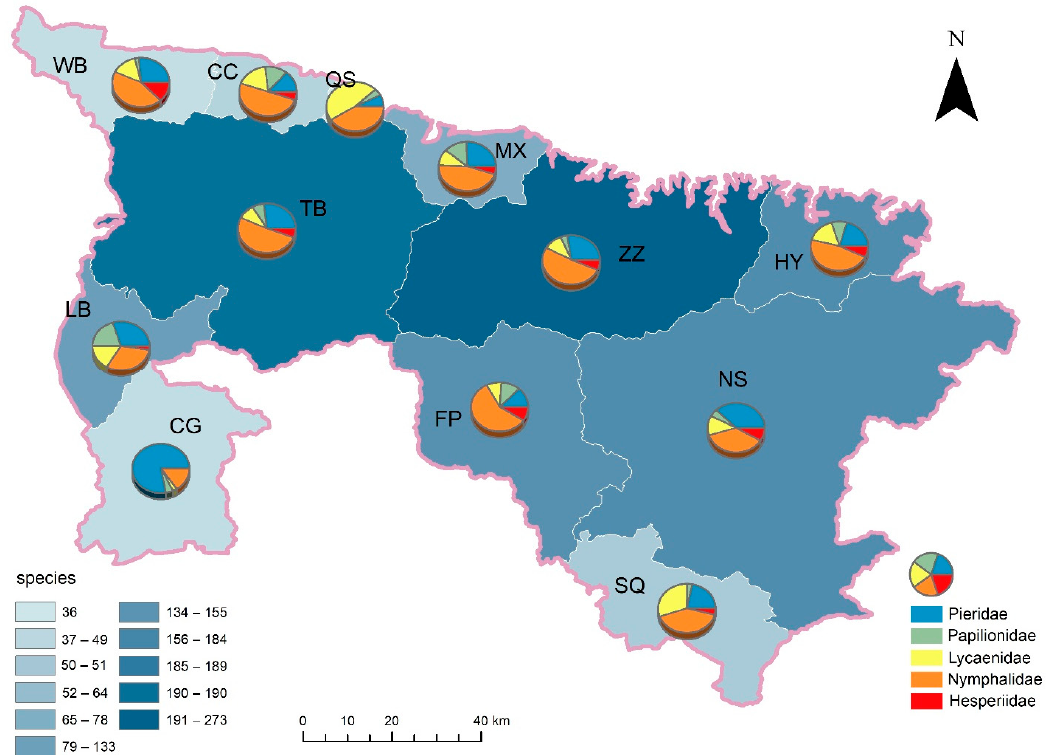
Figure 2. Spatial distribution of species richness in 12 ecoregions. The pie charts represent the pro- portions of 5 butterfly families. The counties are Zhouzhi County (ZZ), Huyi District (HY), Meixian County (MX), Taibai County (TB), Qishan County (QS), Chencang District (CC) and Weibin District (WB), Liuba County (LB), Chenggu County (CG), Foping County (FP), Ningshan County (NS) and Shiquan County (SQ). Table 1. Diversity indices of butterfly communities in the middle Qinling Mountains (mean ± SE). No. of No. of Family Genera